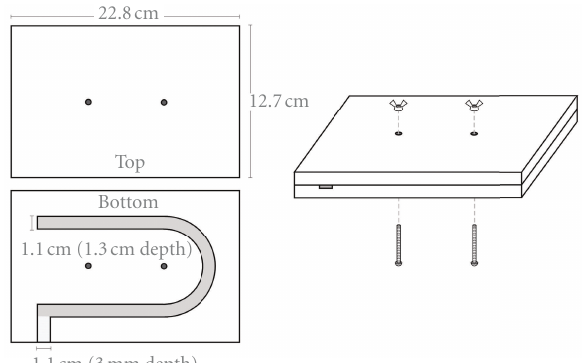
Figure 1: Artificial field nest. The U shape of the bottom half of the nest is excavated to a depth of 1.3 cm and the short section that connects the U to the exterior edge, shown in a lighter shade of gray, to a depth of 3mm. Two holes drilled in each piece allow bolts to be used to hold the two boards